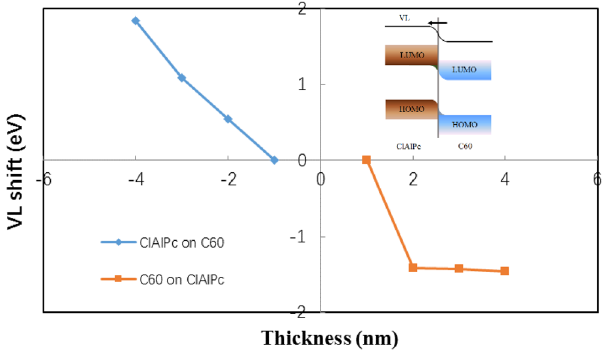
Figure 4. Vacuum level (VL) shift in ClAlPc/C60 heterojunction measured by field emission. Inset: Schematic demonstration of band bending and build-in field direction in ClAlPc/C60 heterojunction.